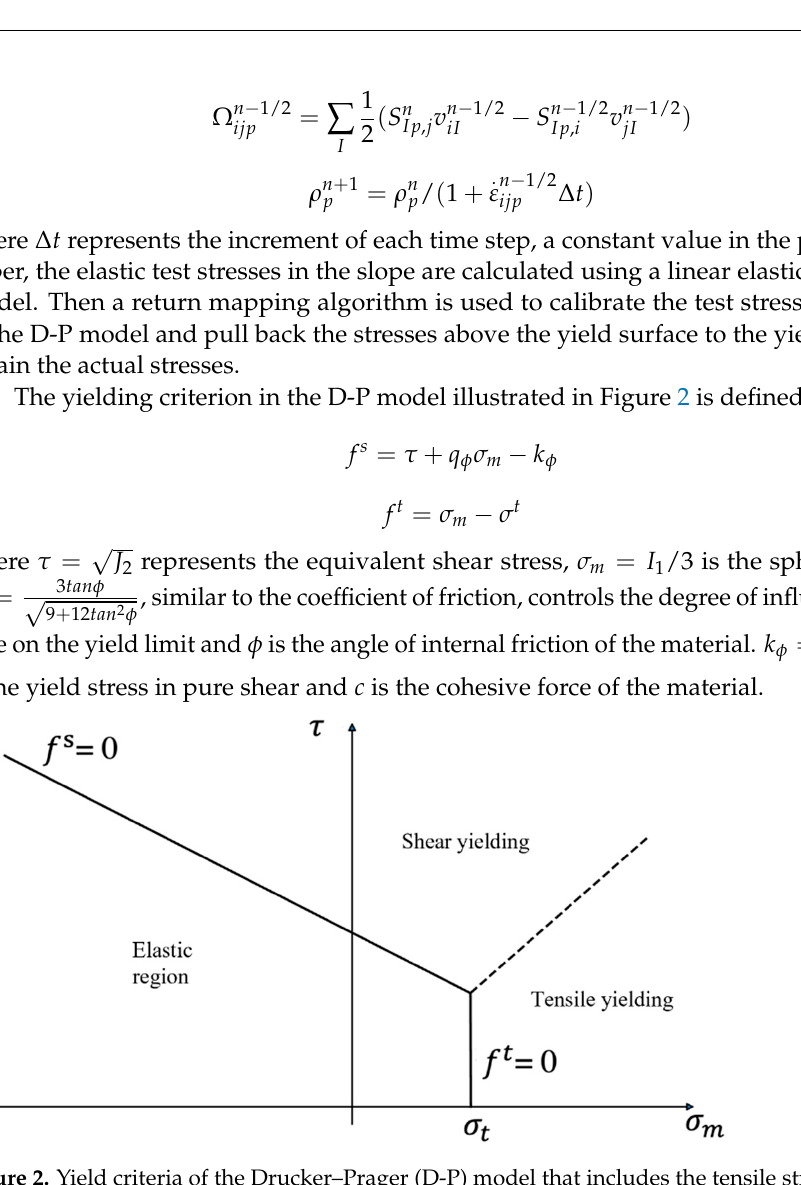
Figure 2. Yield criteria of the Drucker–Prager (D-P) model that includes the tensile stress cut-off. Then the momentum equation can be solved on the grid nodes based on this information.